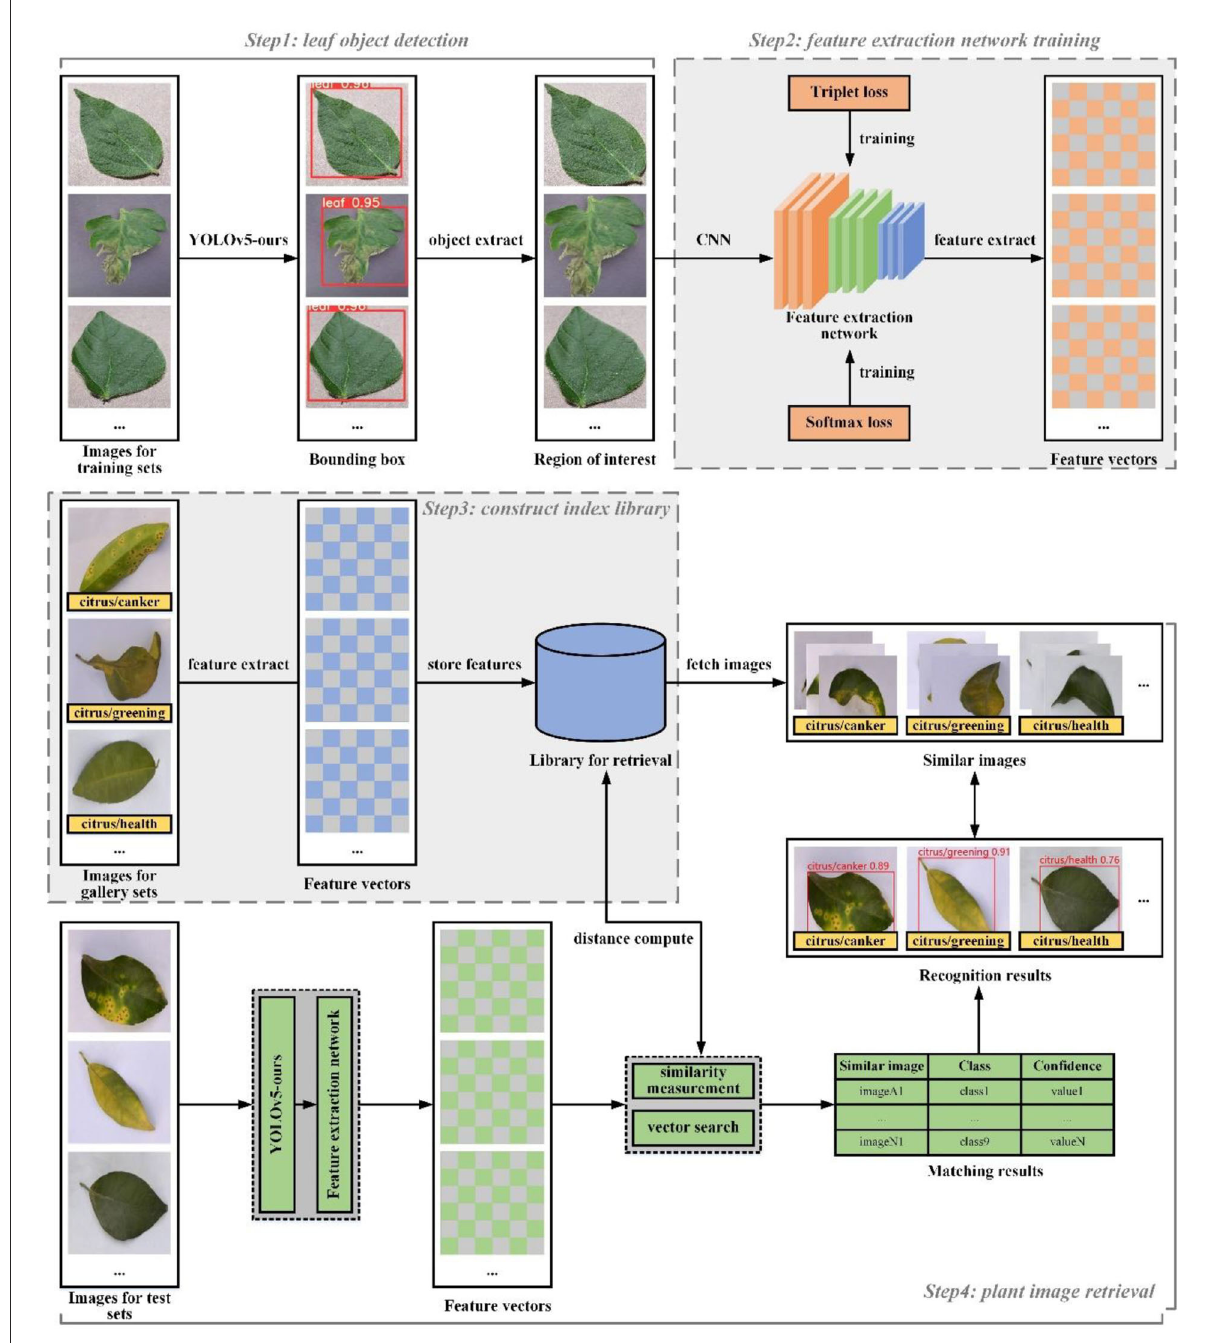
FIGURE3 The framework of our image retrieval